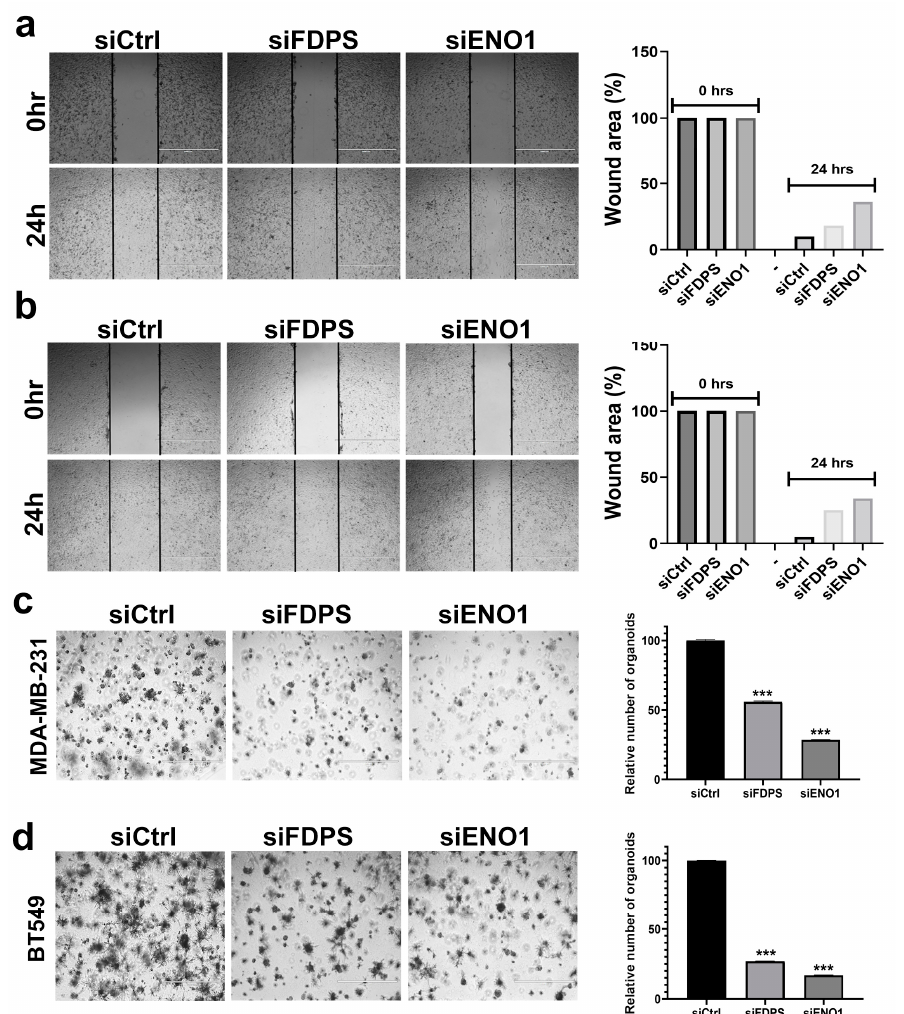
Figure 7. Targeted depletion of FDPS and ENO1 reduces migration and organotypic growth of TNBC cell models. Cell migration (scratch assay) for MDA-MB-231 ( a ) and BT-549 ( b ) TNBC cell models in response to FDPS and ENO1 depletion. Quantification of relative (%) wound area under each treatment condition is shown in the right panels. Inhibition of 3D organoid formation of MDA-MB- 231 ( c ) and BT-549 ( d ) TNBC models in response to FDPS and ENO1 depletion. (Scale bar = 1000 µ M). Quantification of number of organoids under each treatment condition relative to control is shown in the right panels. Data are shown as mean relative number from three different fields (10 × ) ± S.D, n = 3. *** p <